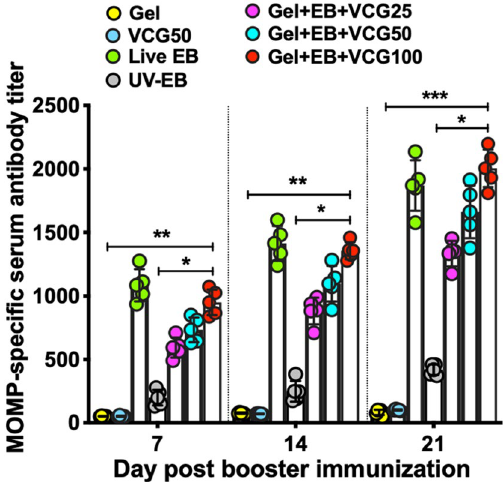
Figure 8. Detection of MOMP-specific antibodies after immunization with UV-inactivated EB in combination with different doses of VCG. Groups of chickens were immunized and boosted IN as described in the materials and methods section. Serum samples were collected from 5 chickens per group on days 7, 14 and 21 after the booster immunization as indicated in the Materials and Methods. MOMP-specific antibody titers were assessed by a MOMP-based antibody ELISA. Results are presented as the reciprocal of the highest serum dilution with an absorbance above the cut-off value (mean negative OD values plus 2 times the SD). The data are from one of two independent experiments with similar results. Significant differences between experimental groups were evaluated by One-way ANOVA with Tukey’s post multiple comparison test at p *** < 0.001, p ** < 0.01 and p * <